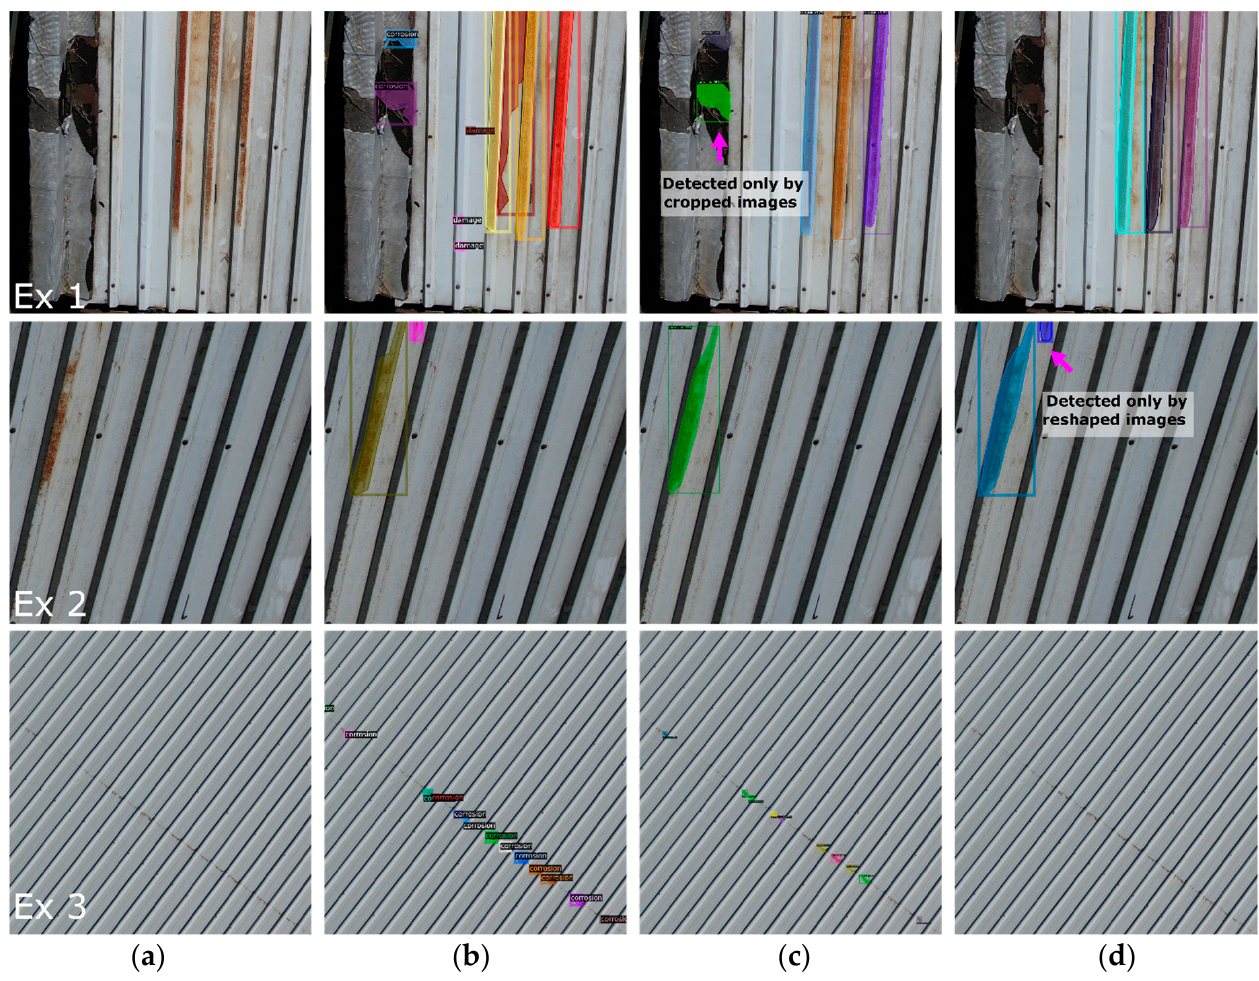
Figure 11. Evaluation of the influence of image size on the efficiency of image classification based on different examples (EX1 to EX3): ( a ) original images, ( b ) ground truth, ( c ) inference with cropped images, and ( d ) inference with resized images.